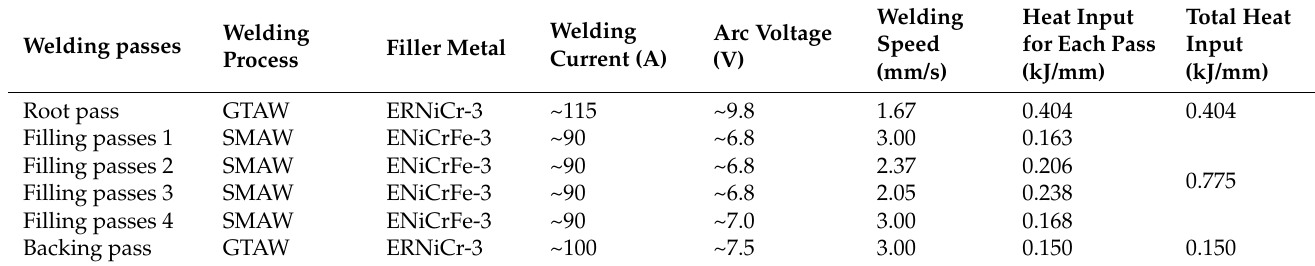
Table 1. Welding parameters for root pass and filling